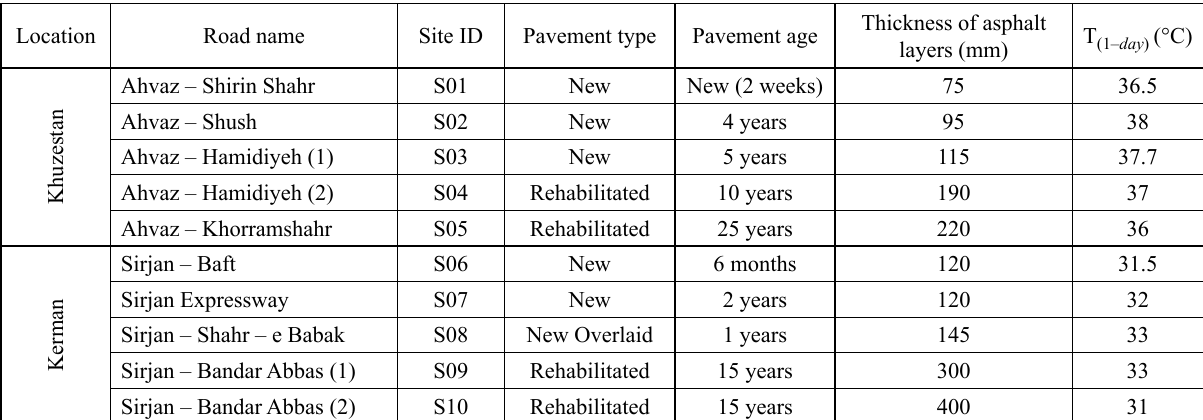
Table 2. General characteristics of the pavement sites